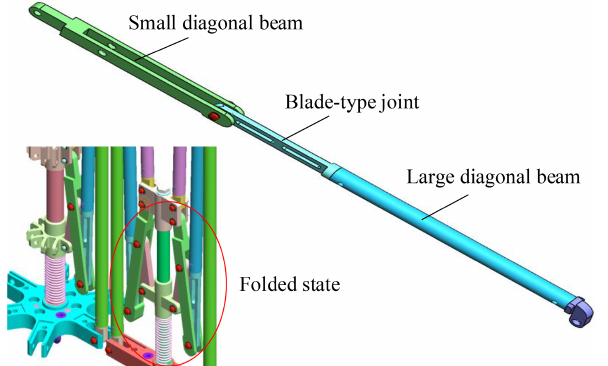
Figure 12. Diagonal beam assembly.